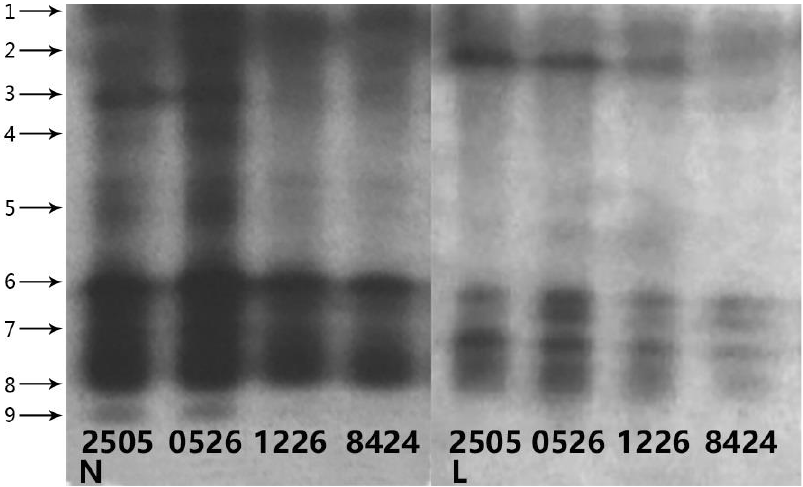
Figure 5. SOD isozymes in leaves of different grafted seedlings (different numbers represent different bands).